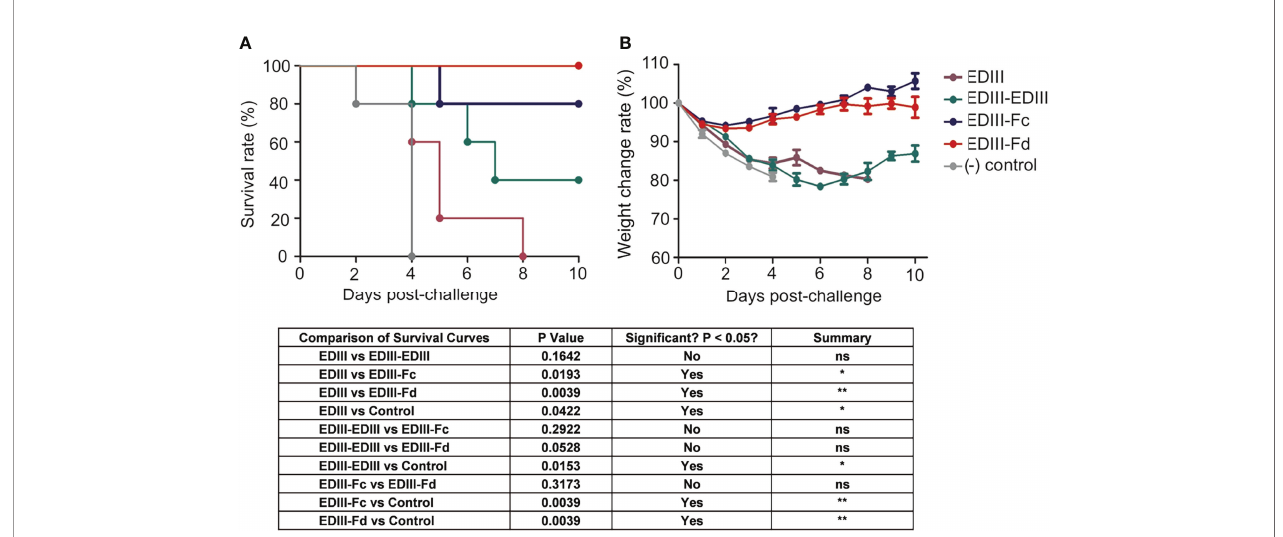
FIGURE 4 | Ef fi cacy of recombinant JEV EDIII fragments in protecting animal models from lethal JEV challenge. Mice were immunized with one of the recombinant EDIII fragments, respectively, and then challenged with JEV (P3 strain, 100× LD 50 ). Challenged mice were observed daily for survival rate (A) and weight change rate (B) . The data are presented as mean ± SD of fi ve mice in each group. *P < 0.05, **P < 0.01 and "ns" means no signi fi cance.